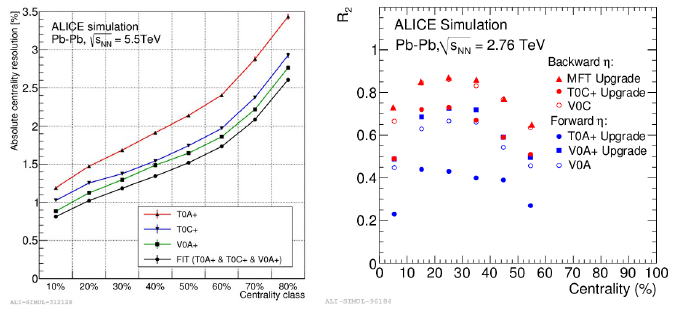
Pb–Pb collisions – HIJING [6]. Electrons from electromagnetic interactions were added as an additional background. The left panel of Fig. 3 shows the registration e ffi ciency for pp col- lisions as a function of event multiplicity. The right panel shows the e ffi ciency as a function of impact parameter for a very peripheral Pb–Pb collisions. The MB trigger conditions used for these calculations were generated as a coincidence between the A and C detectors and OR coincidence. The obtained e ffi ciency was 98.8% for pp and 99.8% for peripheral Pb–Pb collisions.